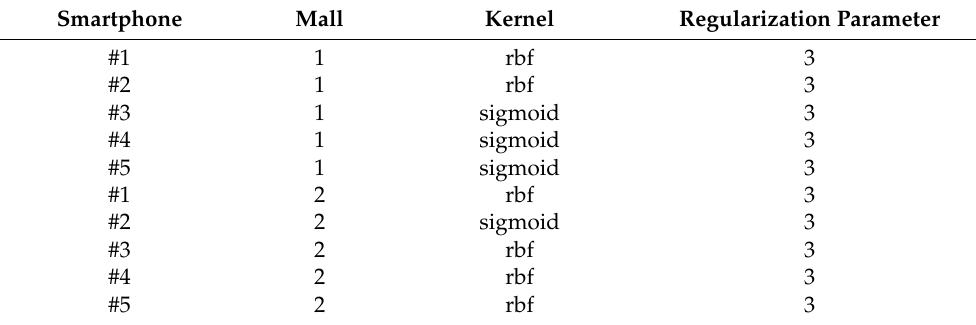
Table 6. Kernel and regularization parameters which have the lowest Euclidean distance errors for